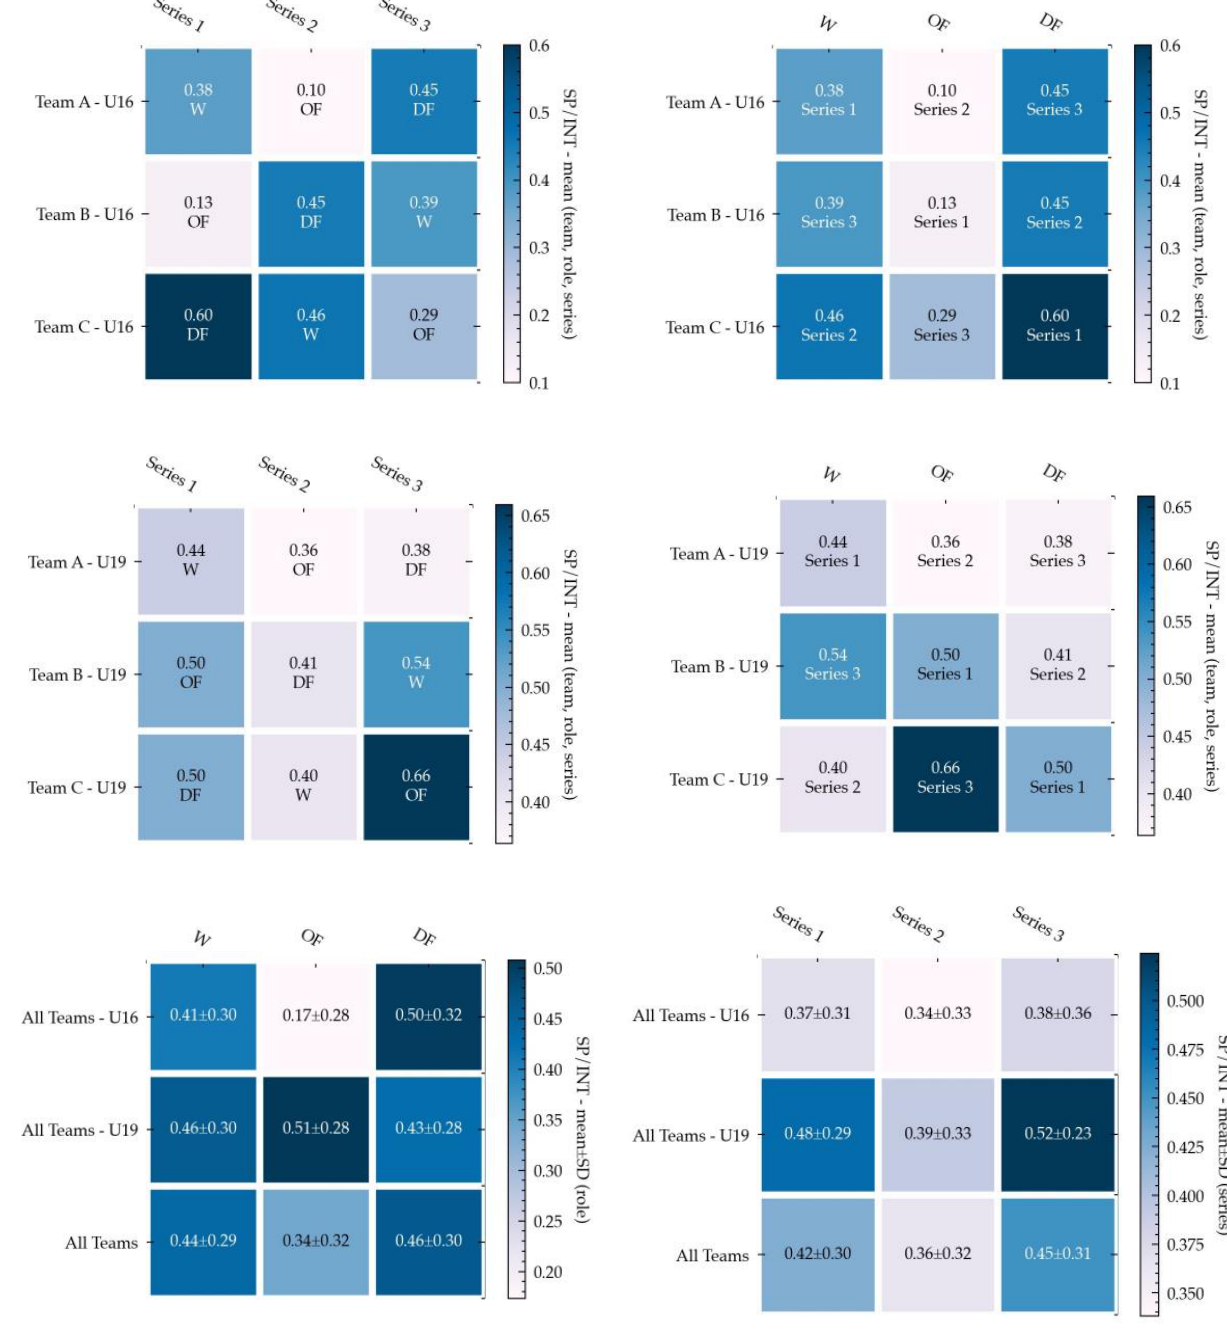
Figure 3. Annotated Heatmaps for the study of the SP/INT variable (U16, U19, and datasets merged). The following figure presents six heatmaps for the study of technical performance in the three datasets studied, in which the first row shows U16 results, the second shows U19 results, and the third shows merged dataset results. The three heatmaps in the left column focus on the comparison among roles (OF, DF, and W), while heatmaps in the right column focus on the comparison between series (Series 1, Series 2, and Series 3). Dark colors show a higher PHYD rate, whereas the light color indicates less prevalence.